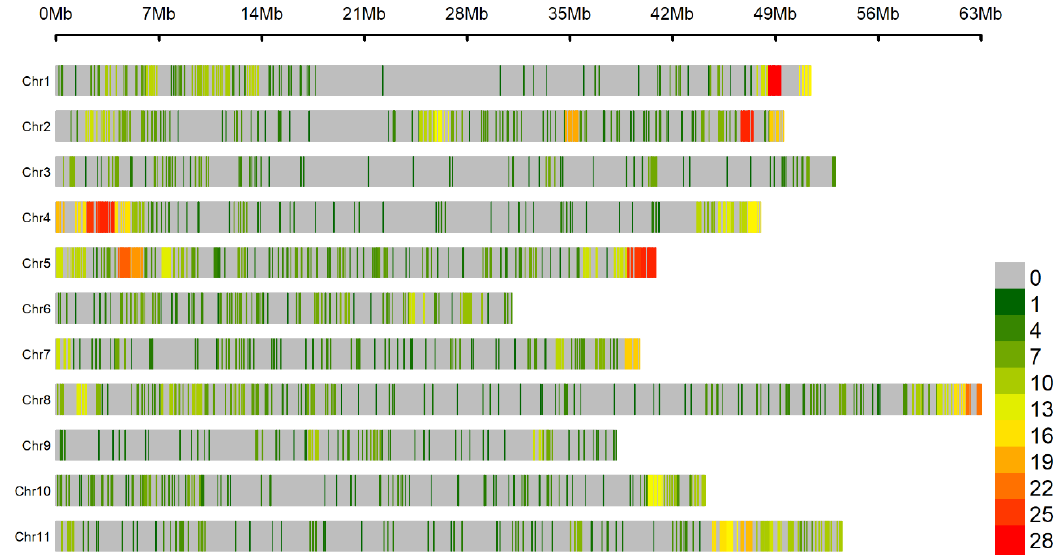
Figure 2. Density of 2001 SNPs in the MDP with 205 Mesoamerican genotypes. The different colors represent different density levels, and “Chr” refers to common bean chromosomes.